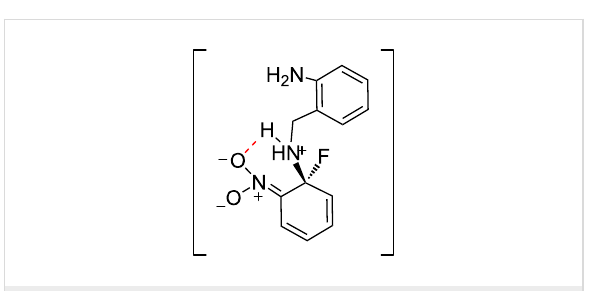
Figure 2: Reaction intermediate in the synthesis of compound 2a